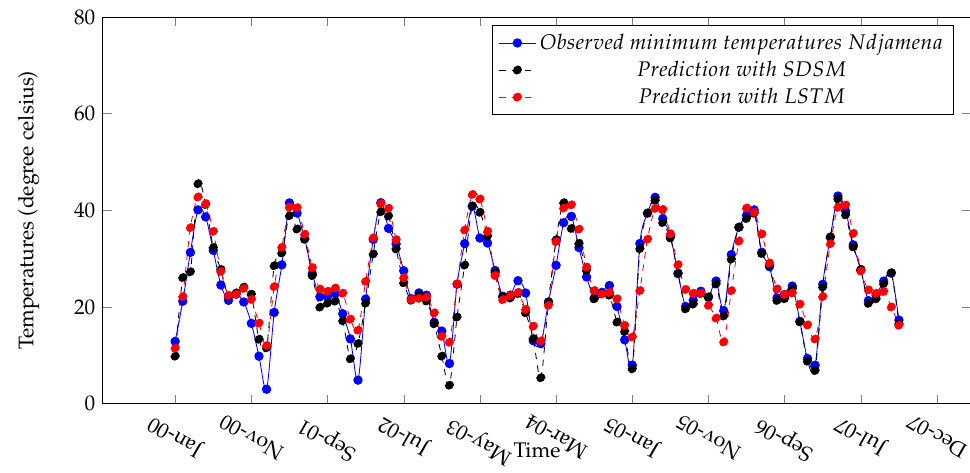
Figure 13. Observed and predicted minimum temperature in Ndjamena.